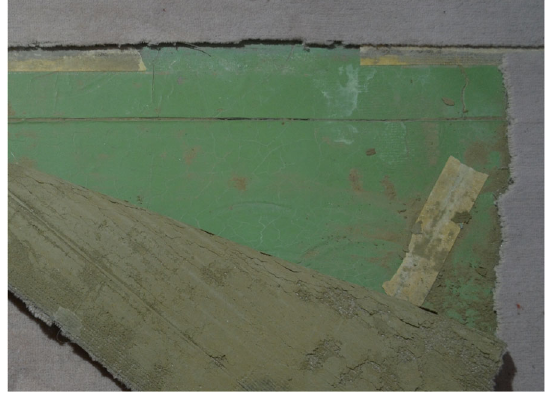
Fig. 26 Josef Frank and Oskar Wlach, House Beer in Vienna Hietzing (1930), attic, northern room with largely preserved green rubber flooring (Source: Ivo Hammer